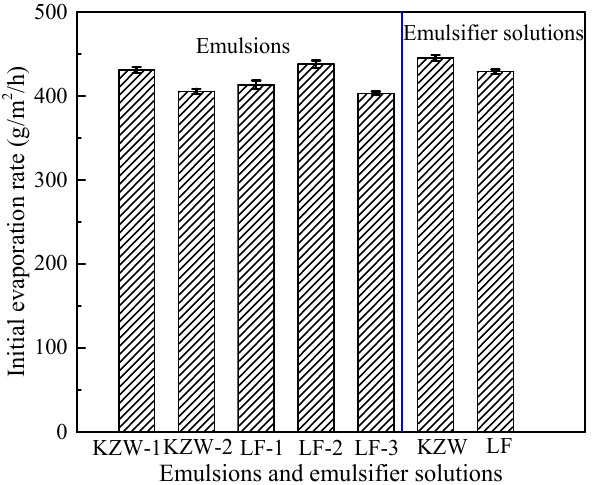
Figure 9. Initial evaporation rate of emulsions and their emulsifier solutions.